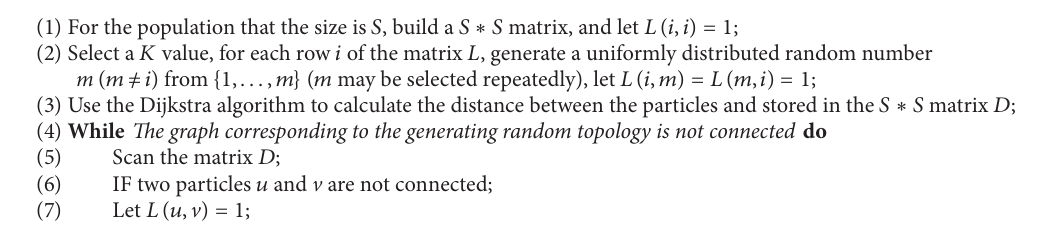
Algorithm 2: The proposed generating method of random population